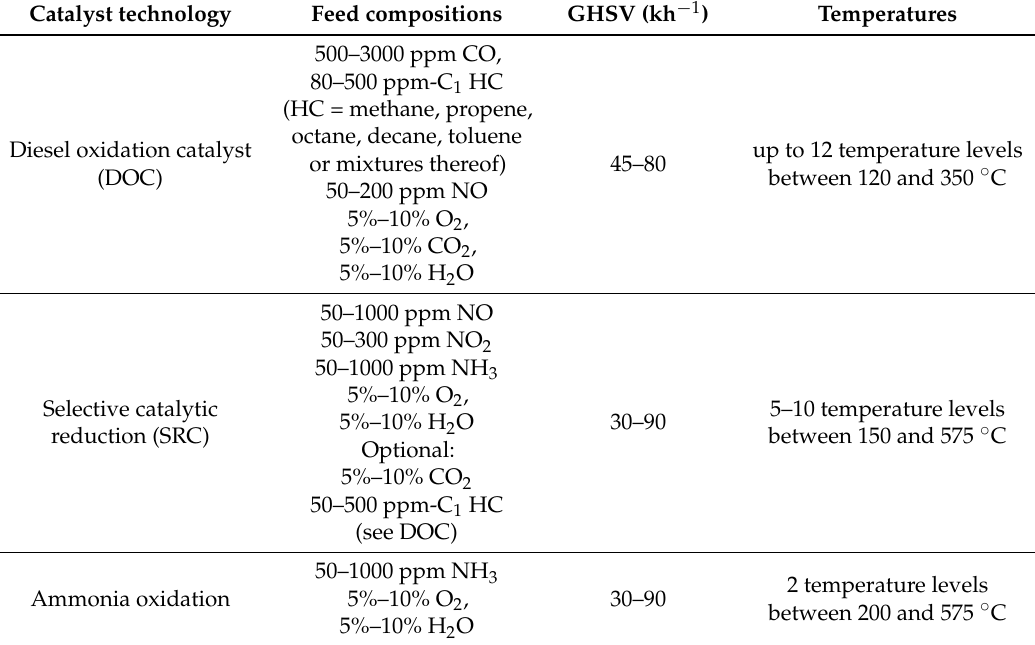
Table 1. Overview of steady-state test